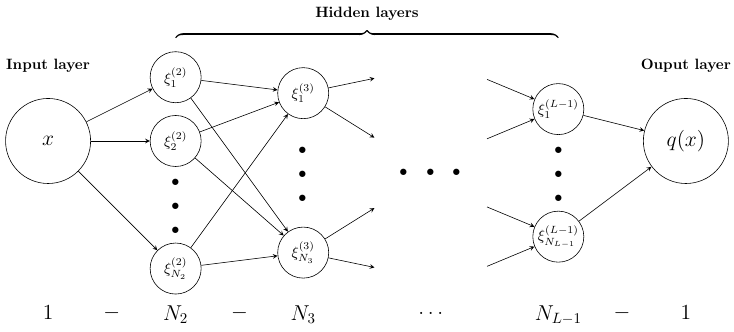
Figure 3 . A neural network can be used as a general parametrization of an unknown function from IR N 1 IR N L . For the case of a PDF, a single valued function of a single argument, the input and ! output layers have only one